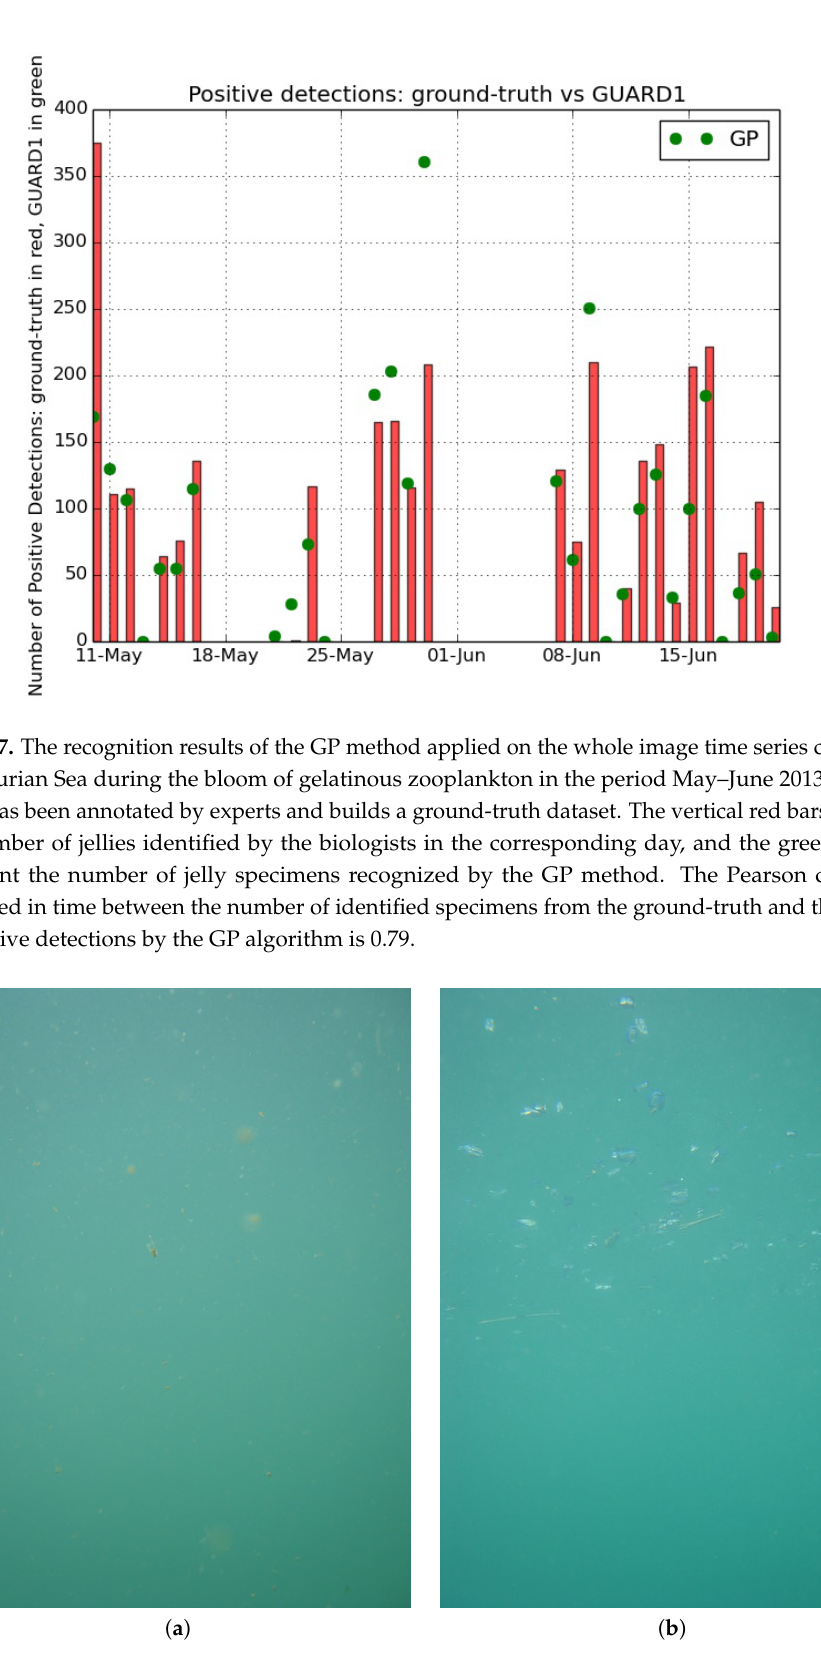
Figure 8. Examples of images including massive presence of particulate ( a ) and of the hydrozoan Velella velella , visible in the upper part of ( b ), shaded in